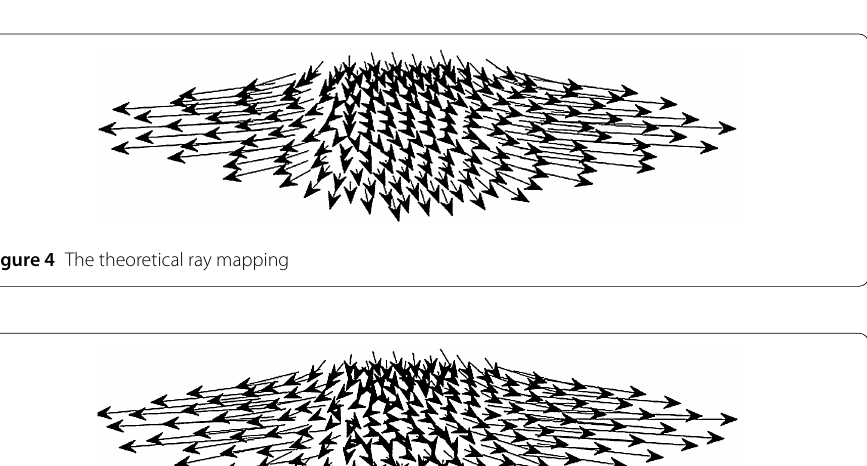
Figure 3 The sampling of the wave’s intensity